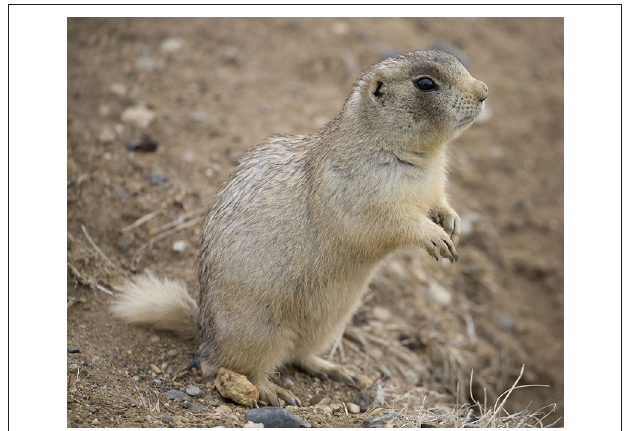
FIGURE 1 | Adult white-tailed prairie dog at Arapaho National Wildlife Refuge, Colorado. Photo by Elaine Miller Bond, www.elainemillerbond.com (Reproduced with permission).